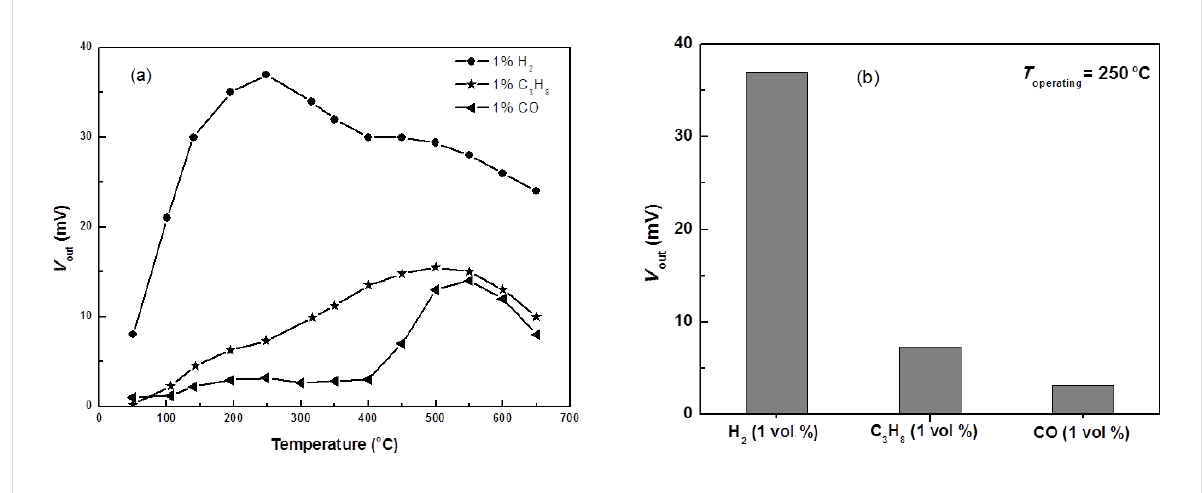
Figure 5: The operating temperature-dependence of (a) the sensitivity and (b) the specificity of the Pd/ZnO sample at 1 vol % of H 2 , CO and C 3 H 8 with a humidity of 65% RH.